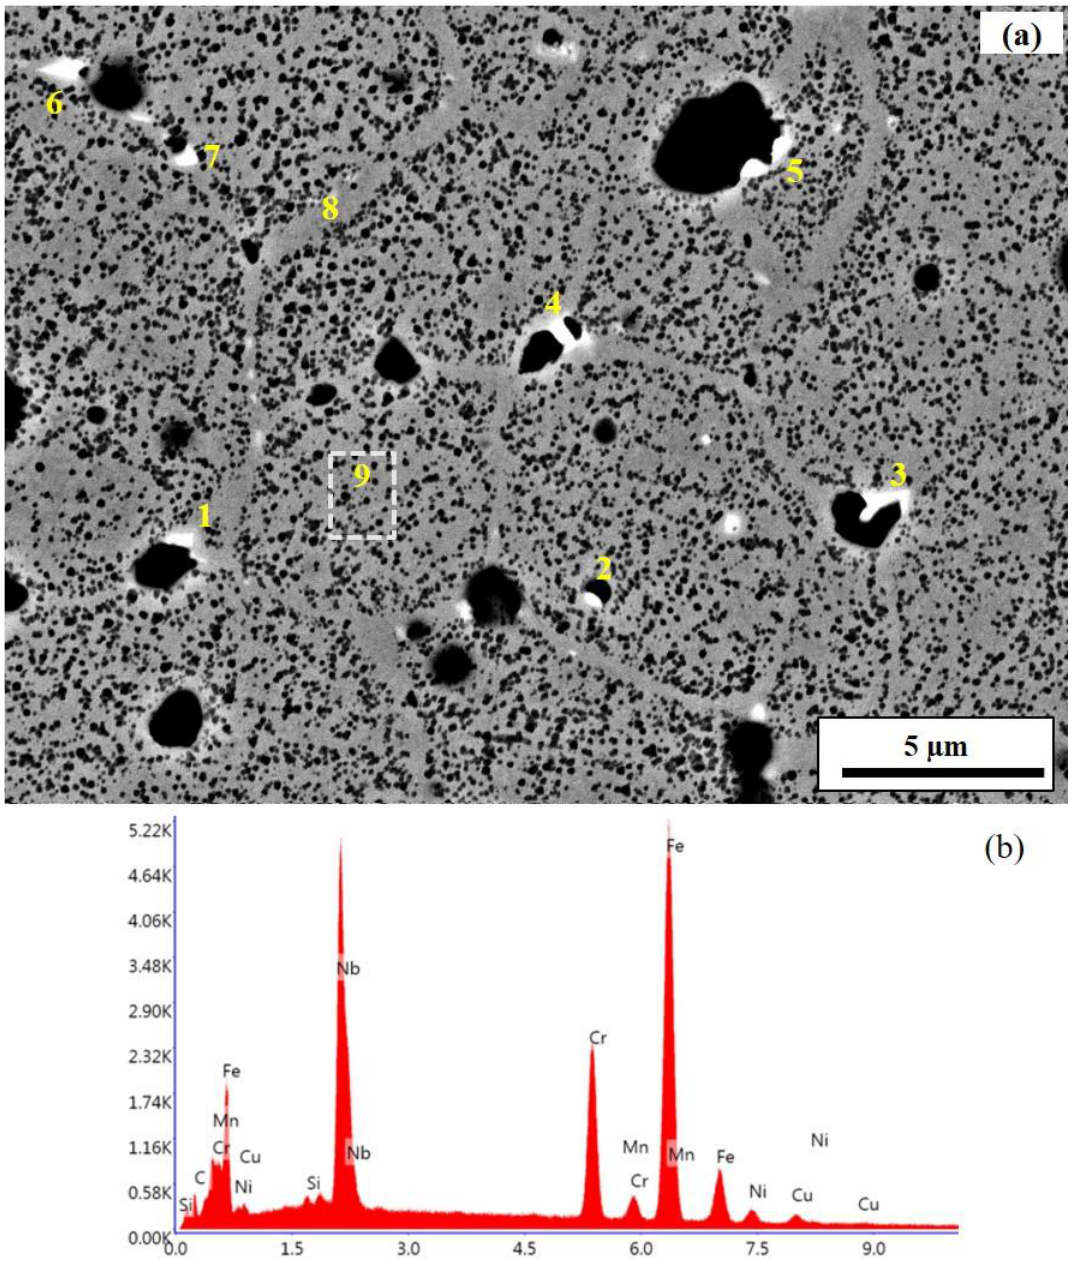
Figure 8. EDS elemental composition analysis of Nb-rich precipitates in AP: ( a ) back-scattered SEM image and ( b ) typical EDS spectrum. The horizontal axis of the EDS spectrum is the energy in keV, whereas the vertical axis is the number of X-ray counts or intensity. ( Note: The “K” in the vertical axis is equivalent to 1000, i.e., 1000 is multiplied to the numbers in the vertical axis). Table 4. The concentration of Nb at the spots shown in Figure